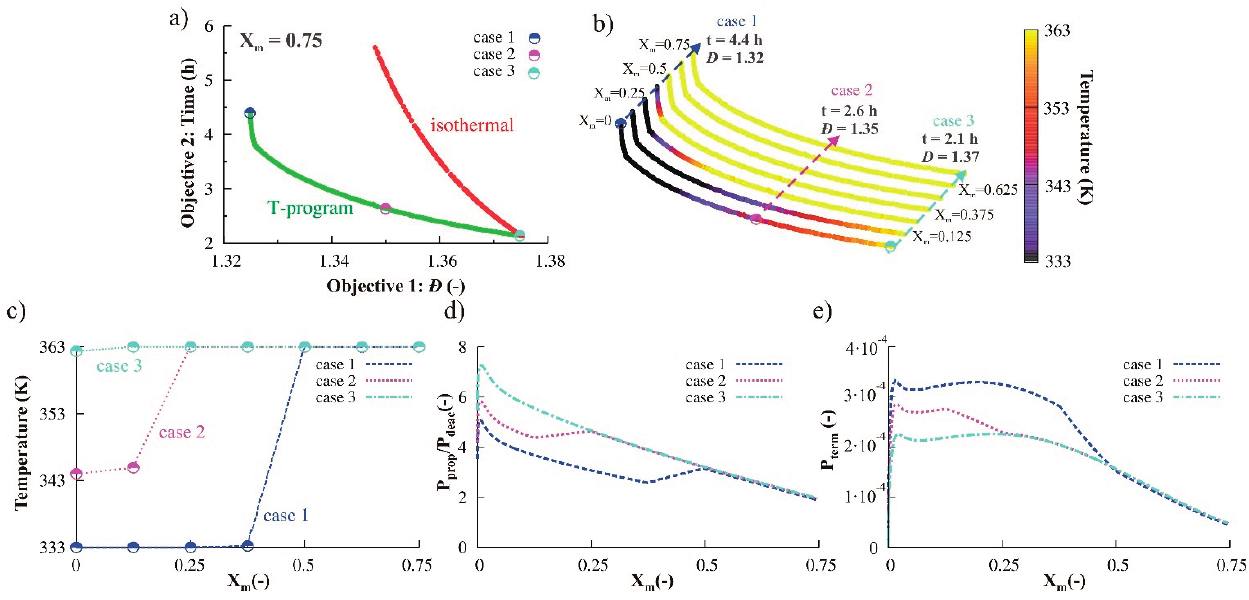
Figure 2. Results for the multi-objective optimization (MOO) of ARGET ATRP of BMA using a piecewise linear temperature program ( Δ X m = 0.125 until X m = 0.75; [ M ] 0 /[ R 0 X ] 0 /[ Cu II X 2 /L ] 0 /[ Sn II (EH) 2 ] 0 = 200/1/0.005/0.05) ( a ) Pareto-optimal front (green circles) and corresponding isothermal front (red circles); ( b ) Variation of the temperature at the interval boundaries along the Pareto-optimal front; ( c ) Temperature as a function of X m for three selected cases in (a); ( d ) Ratio of probability for propagation to deactivation as a function of X m for the selected cases; and ( e ) Probability for termination as a function of X m for the selected